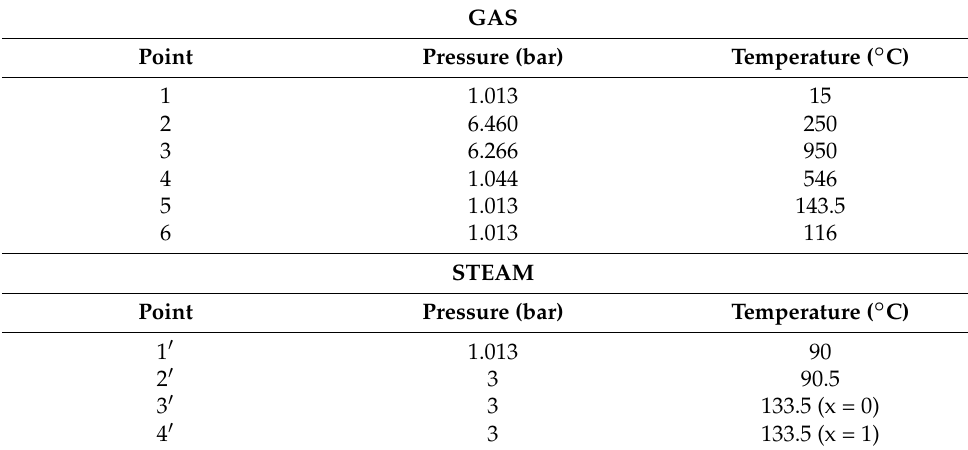
Table 2. Thermodynamic properties of gas and steam.